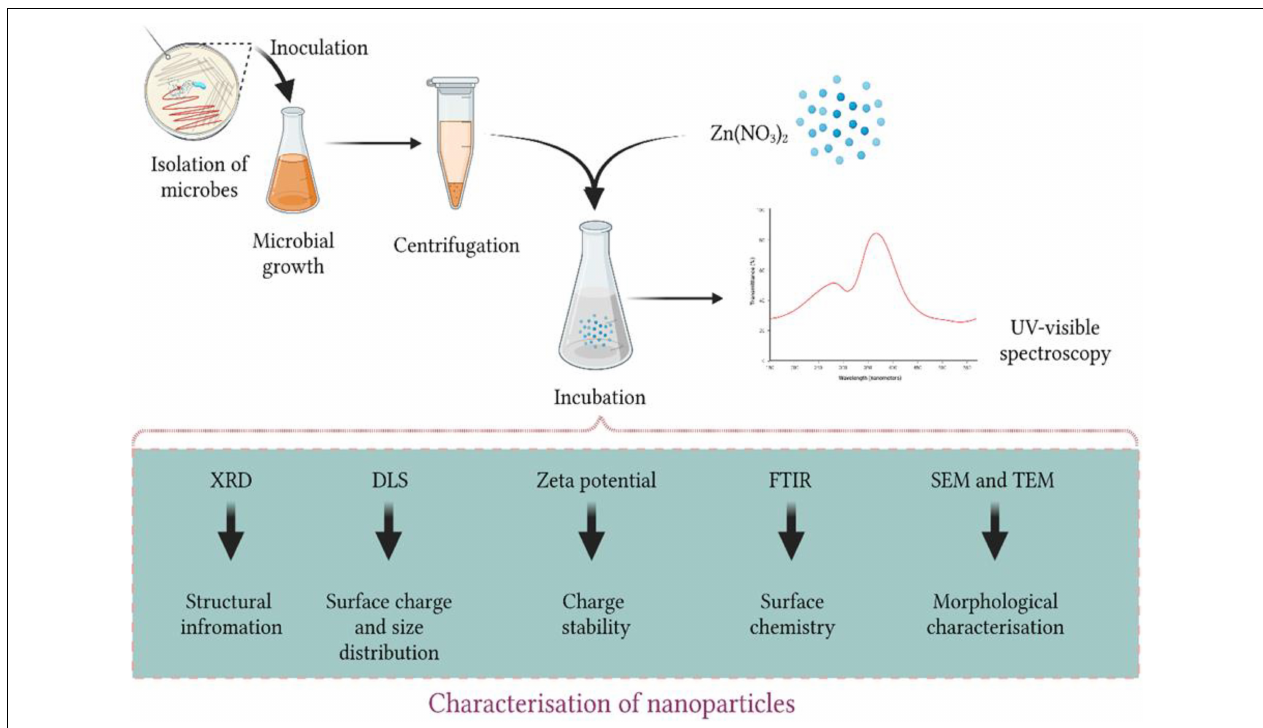
FIGURE 2 | Microbe-mediated synthesis of